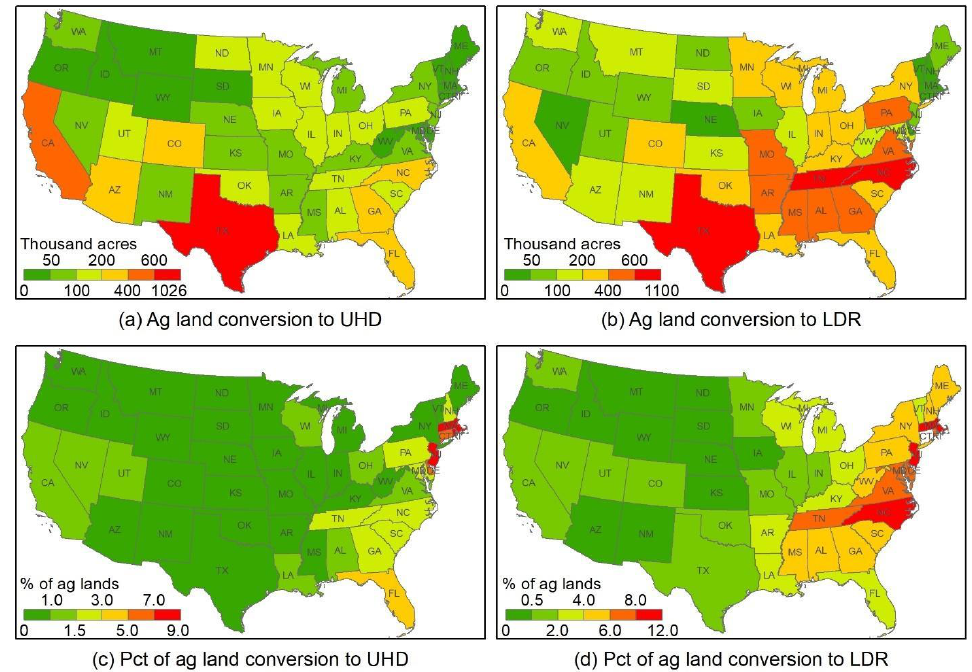
Figure 9. Per-state area and percent of agricultural lands conversion to urban and highly developed (UHD) and low-density residential (LDR) land uses by 2040. ( a ) area of agricultural land conversion to UHD, ( b ) area of agricultural land conversion to LDR, ( c ) percentage of agricultural land conversion to UHD, and ( d ) percentage of agricultural land conversion to LDR. Particular hotspots of conversion are even more apparent at the level of counties and metropolitan areas (Figure 10). Shockingly, ten different counties in Georgia would see over 40% of their agricultural land converted (to UHD and LDR) as the Atlanta megalopolis expands. Three Texas counties — Tarrant, Harris, and Dallas — would convert